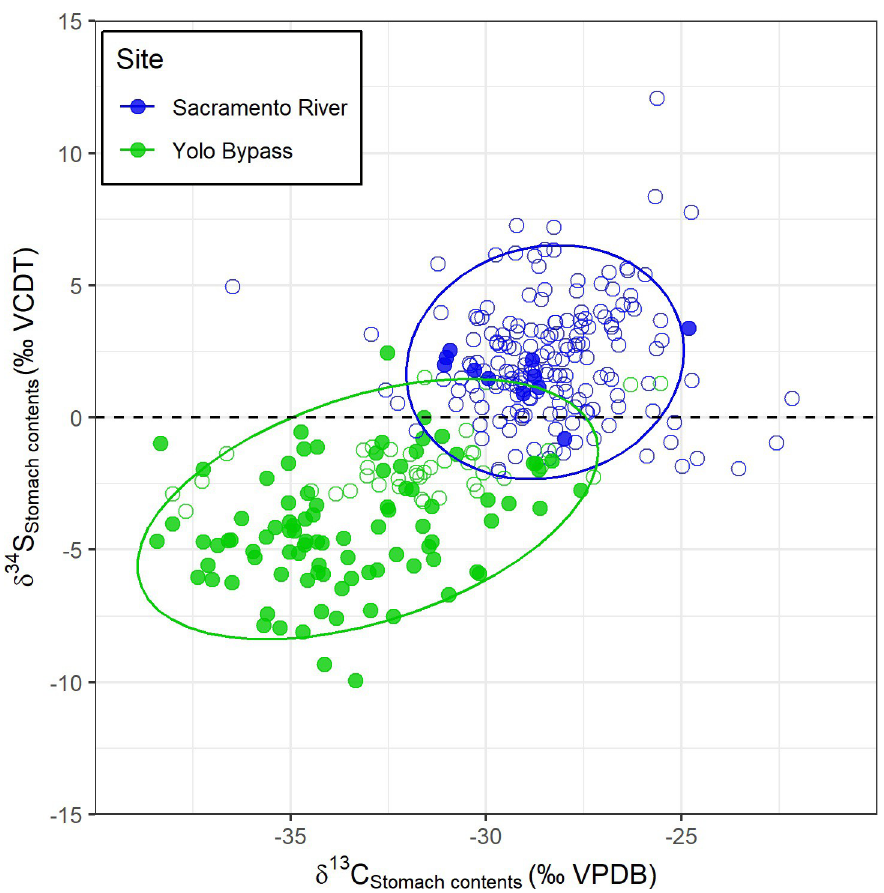
Fig 3. δ 13 C and δ 34 S values from stomach contents from the same fish analyzed for diet composition. Fish captured/reared from the floodplain are shown in green and from the river in blue. Open circles represent fish captured in the river or naturally recruited onto the floodplain while closed circles represent fish from field and caged experiments. Ellipses represent 95% confidence intervals.